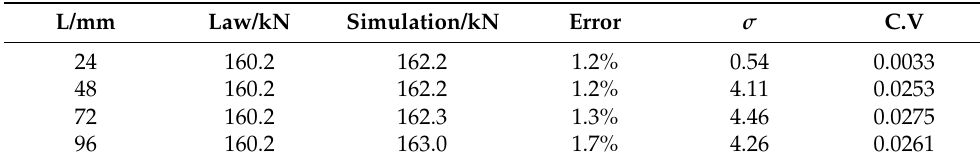
Table 7. The comparison of the friction force of the finite element simulation with different slotted bolt holes length.